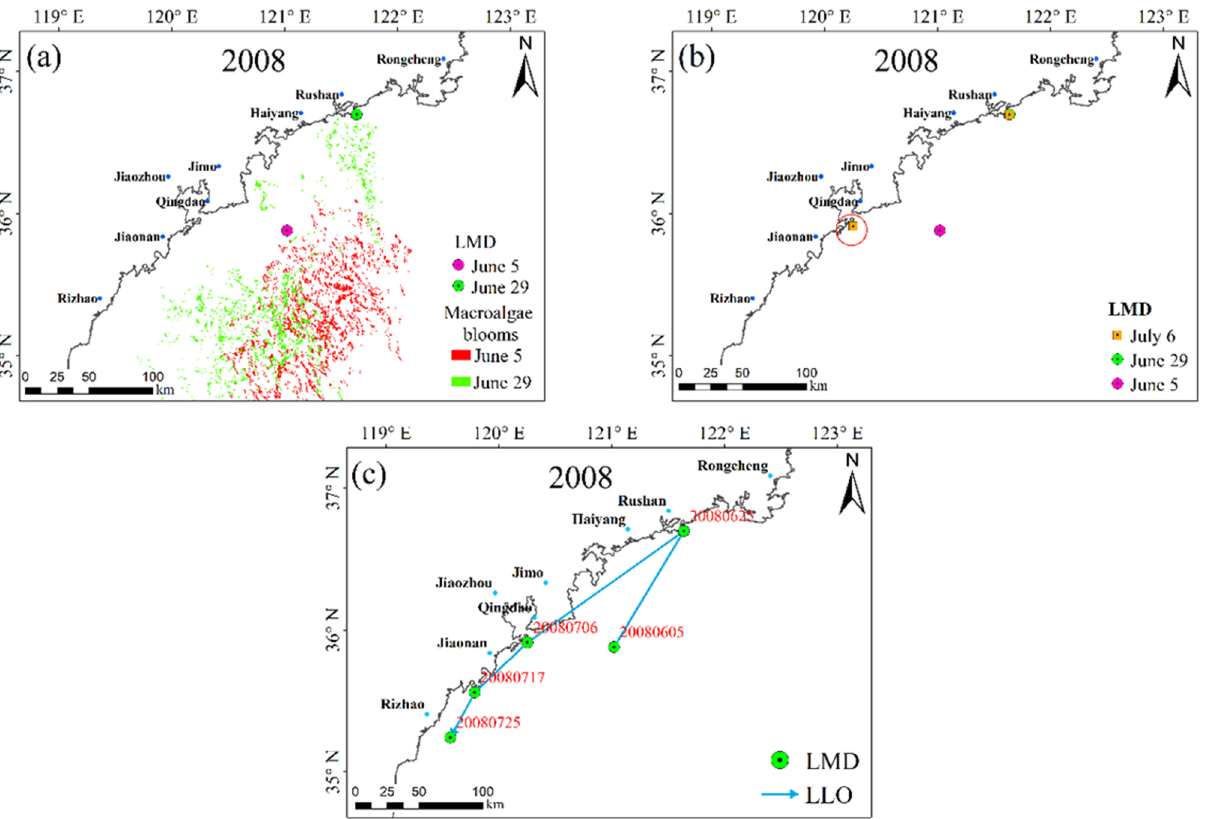
Figure 4. ( a ) Location of minimum distance from offshore (LMD) on 5 June and 29 June 2008. ( b ) The selection of LMD on 6 July 2008, and the point in red circle is LMD selected on 6 July 2008. ( c ) The order in which the macroalgae landed in the coastal cities of Shandong Peninsula (LLO) in 2008.